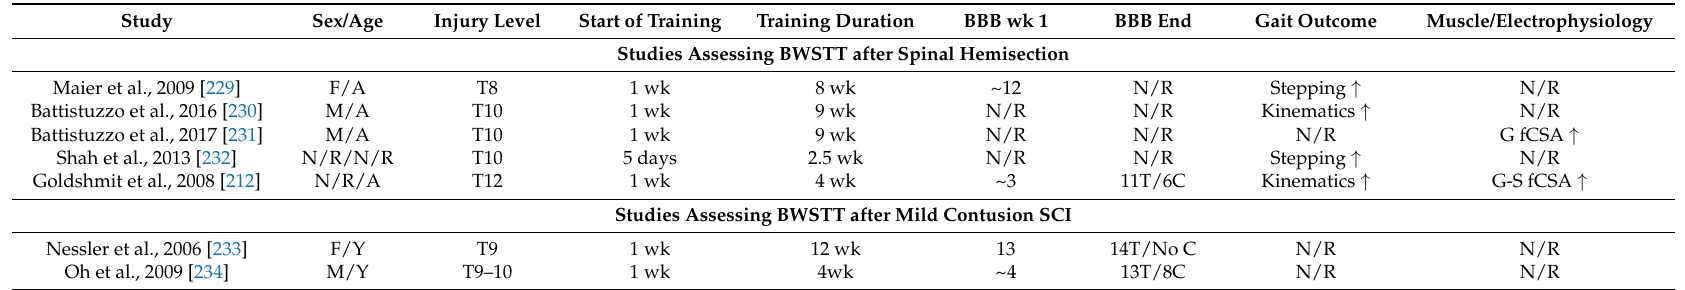
Table 2. Characteristics of Bodyweight Supported Treadmill Training (BWSTT) in Rodent SCI